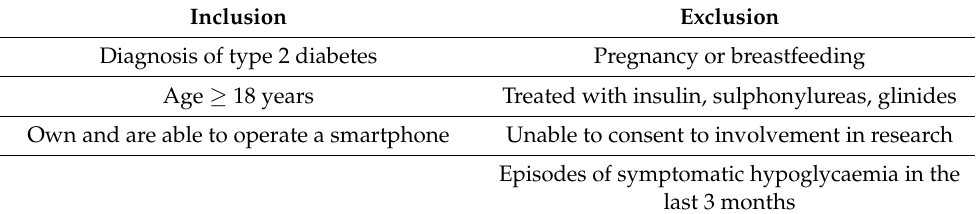
Table 1. Eligibility